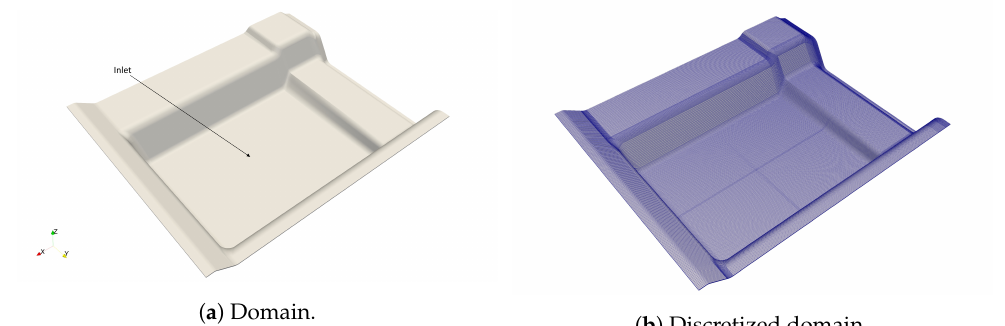
Figure 7. Complicated geometry used for energy modelling comparison. Image ( a ) shows an isometric view of the domain, while image ( b ) shows a surface mesh to illustrate the grid distribution with respect to geometric features.